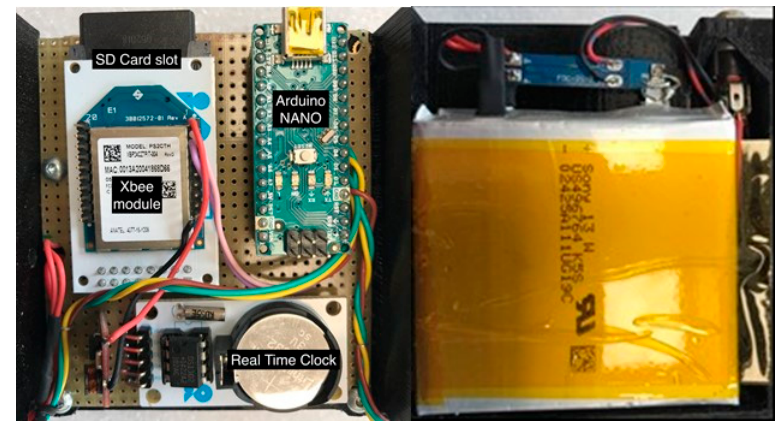
Figure 9. Emitter module front and rear view.